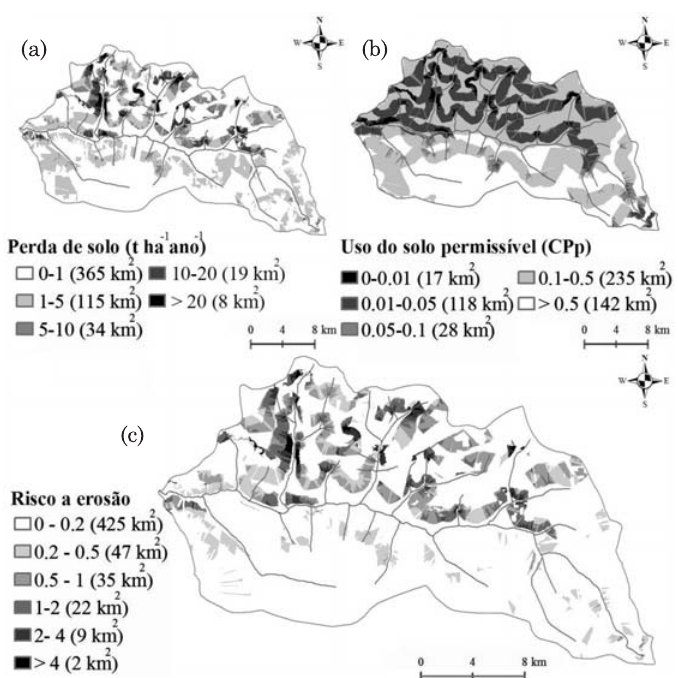
Salobra.Figura 3. Perda de solo estimada pela USLE (a); Uso do solo permissível (b); e Risco de erosão